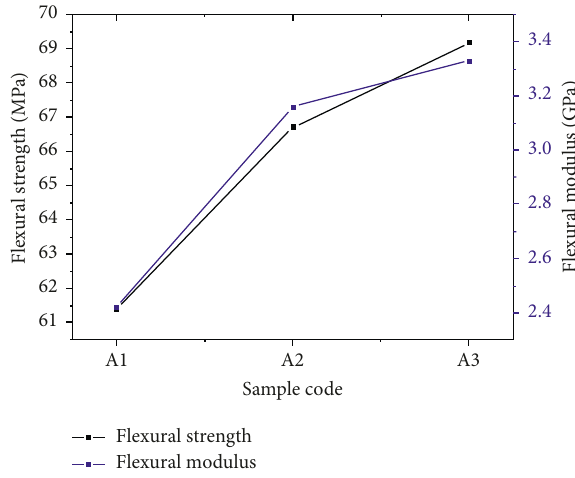
Figure 5: Flexural strength and modulus